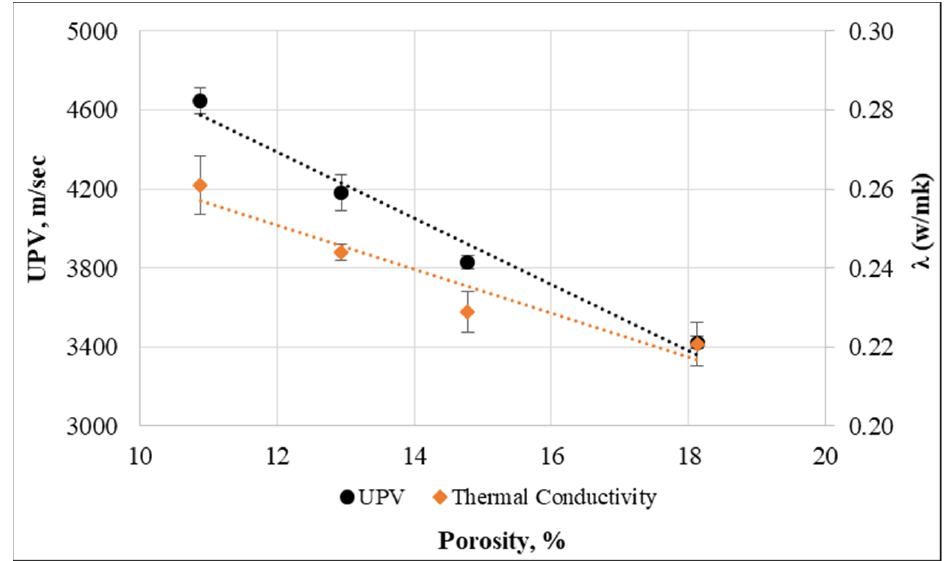
Figure 29. Relationship between UPV, thermal conductivity, and porosity. Furthermore, Figure 30 displays the relationship between UPV, thermal conductivity, and the compressive strength of concrete. The lines trend and their R 2 coefficient clearly indicate that UPV and thermal conductivity could correlate with the compressive strength in an accurate manner. Here, the UPV value and thermal conductivity can be found from the compressive strength with the help of the following formulas: V = 79.359 f cm + 2323.1 λ = 0.0027 f cm +